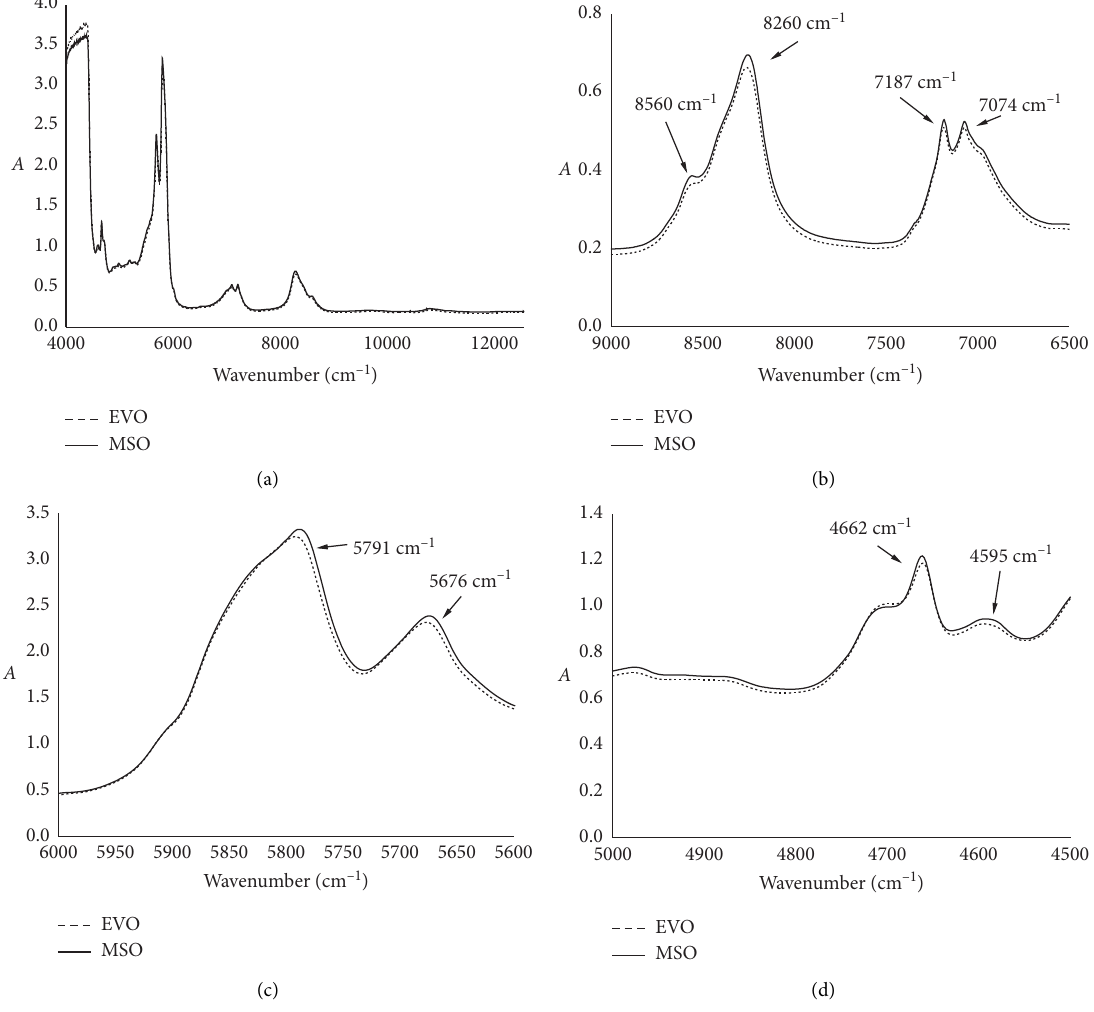
Figure 2: NIR spectra of EVO and MSO. (a) Full spectra 12500–4000 cm − 1 , (b) spectral range 9000–6500cm − 1 , (c) spectral range 6000–5600cm − 1 , (d) spectral range 5000–4500cm − 1 [source: own